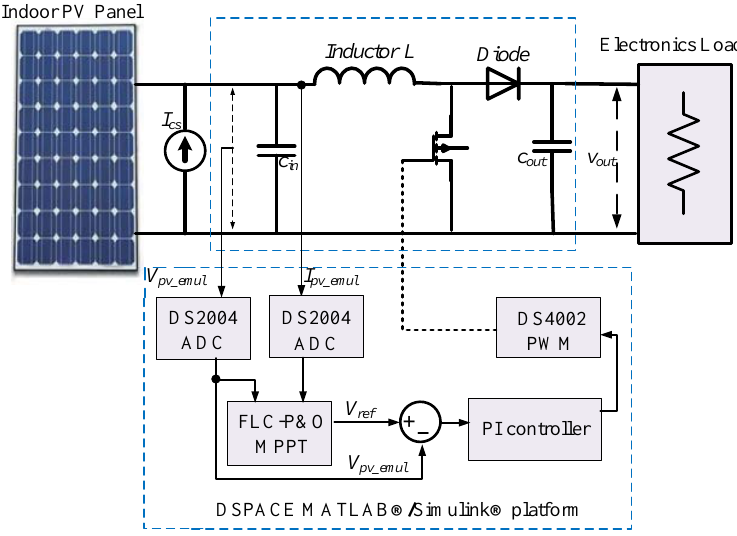
Figure 10. Block diagram of the experiment system for testing the MPPT algorithm.